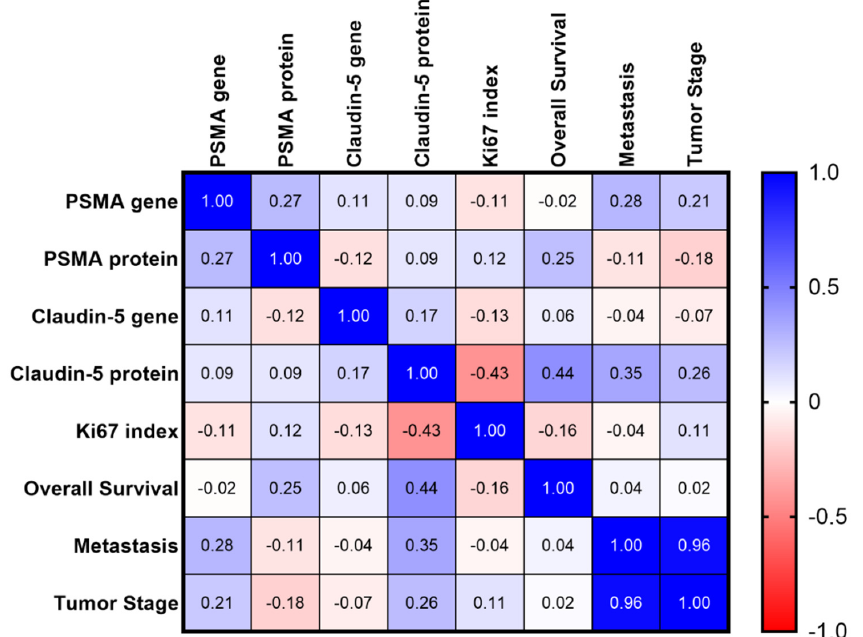
Figure 6. Matrix of multiple correlations for all studied markers. Positive correlations are shown in blue and negative correlations are shown in red. The strength of correlations is depicted by color intensity.